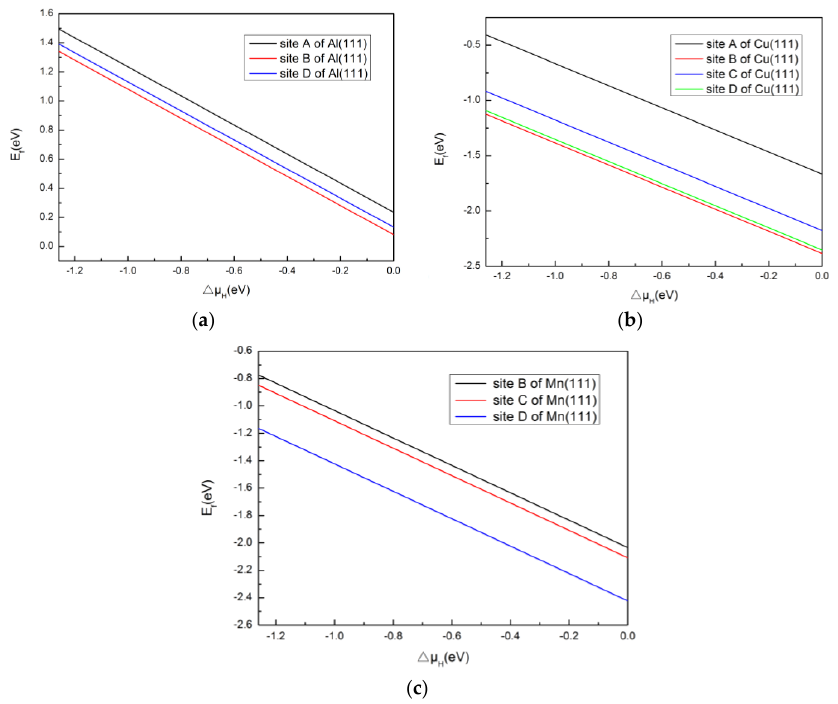
Figure 4. Formation energy of H adsorption on ( a ) Al(111), ( b ) Cu(111) and ( c ) Mn(111) as function of the relative chemical potential of H.